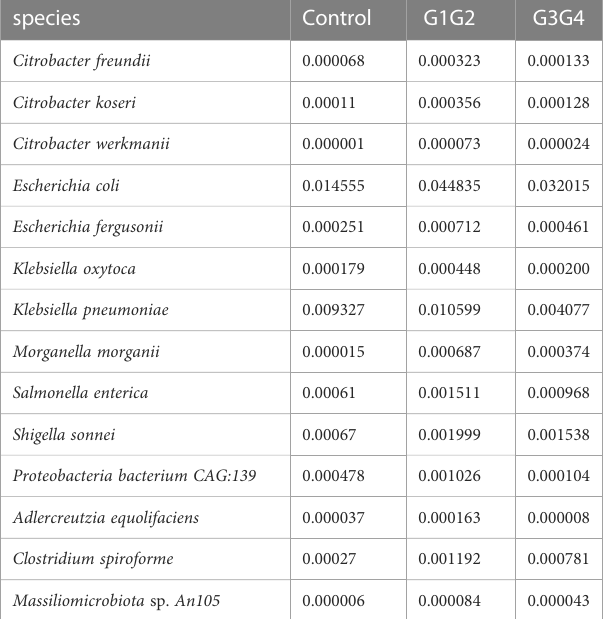
TABLE 7 Relative abundance of differential strains enriched in the G1G2 group.